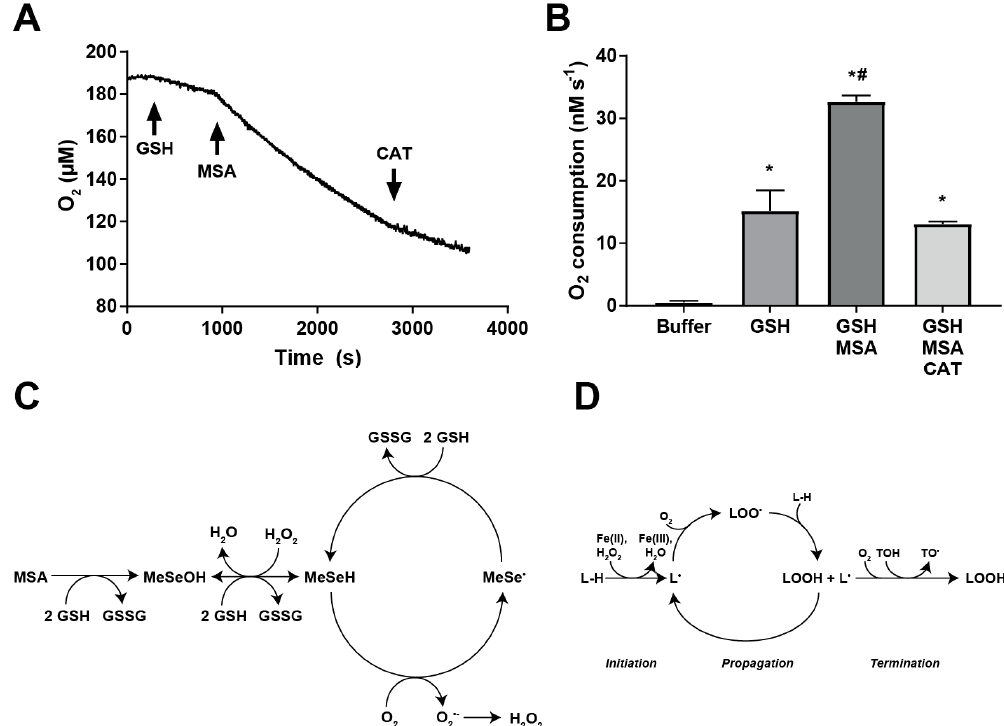
Figure 5. MSA enhances the consumption of O 2 by glutathione. ( A ) Representative trace of O 2 concentration in 3.00 mL pH 9.2 50 mM borate buffer at 37 °C. GSH and MSA added to a final concentration of 2 mM and 250 µM, respectively, at indicated time points. ( B ) Rate of O 2 consumption